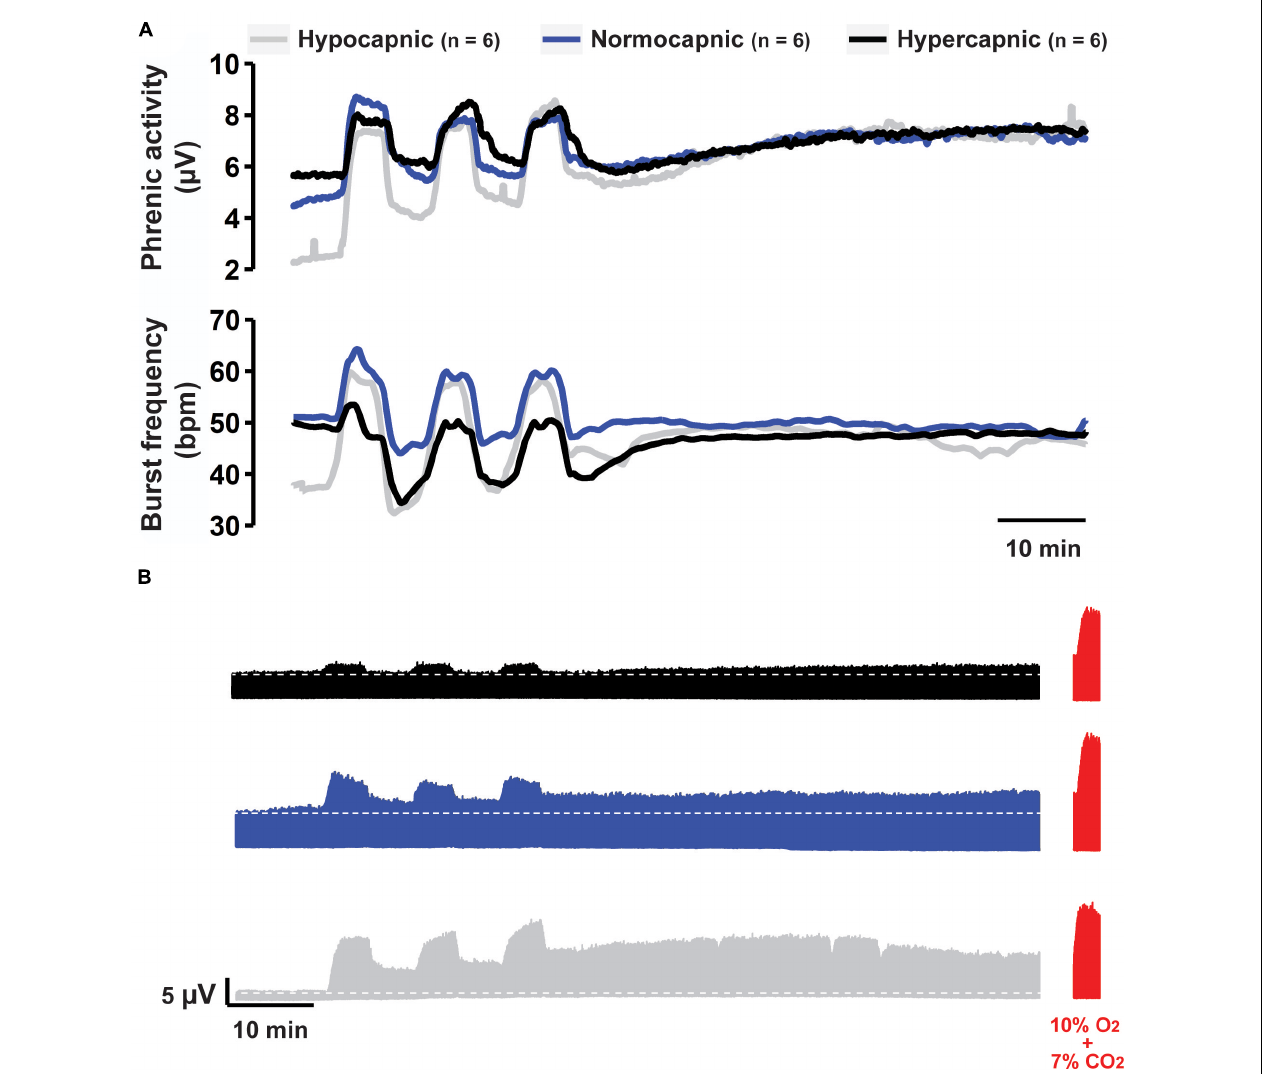
FIGURE 1 | Overall summary of our findings. (A) Average traces of phrenic activity (top) and burst frequency (bottom) throughout the mAIH protocol from rat groups kept under constant hypocapnia (gray line), normocapnia (blue line) or hypercapnia (black line). (B) Group-representative phrenic neurograms during mAIH protocol. At the end of each experiment (shown in red), maximal phrenic output was assessed with 10% oxygen plus 7% CO 2 (i.e., maximal chemoreflex stimulation,